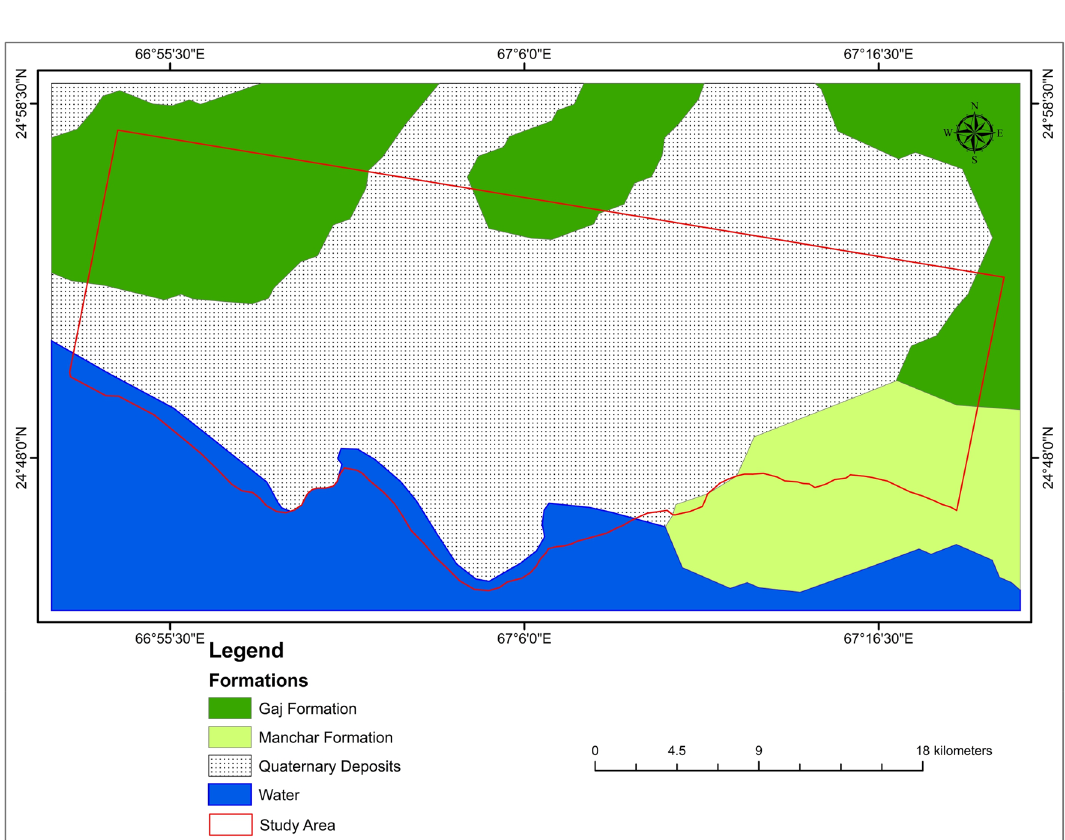
Figure 3. Geological map of the research